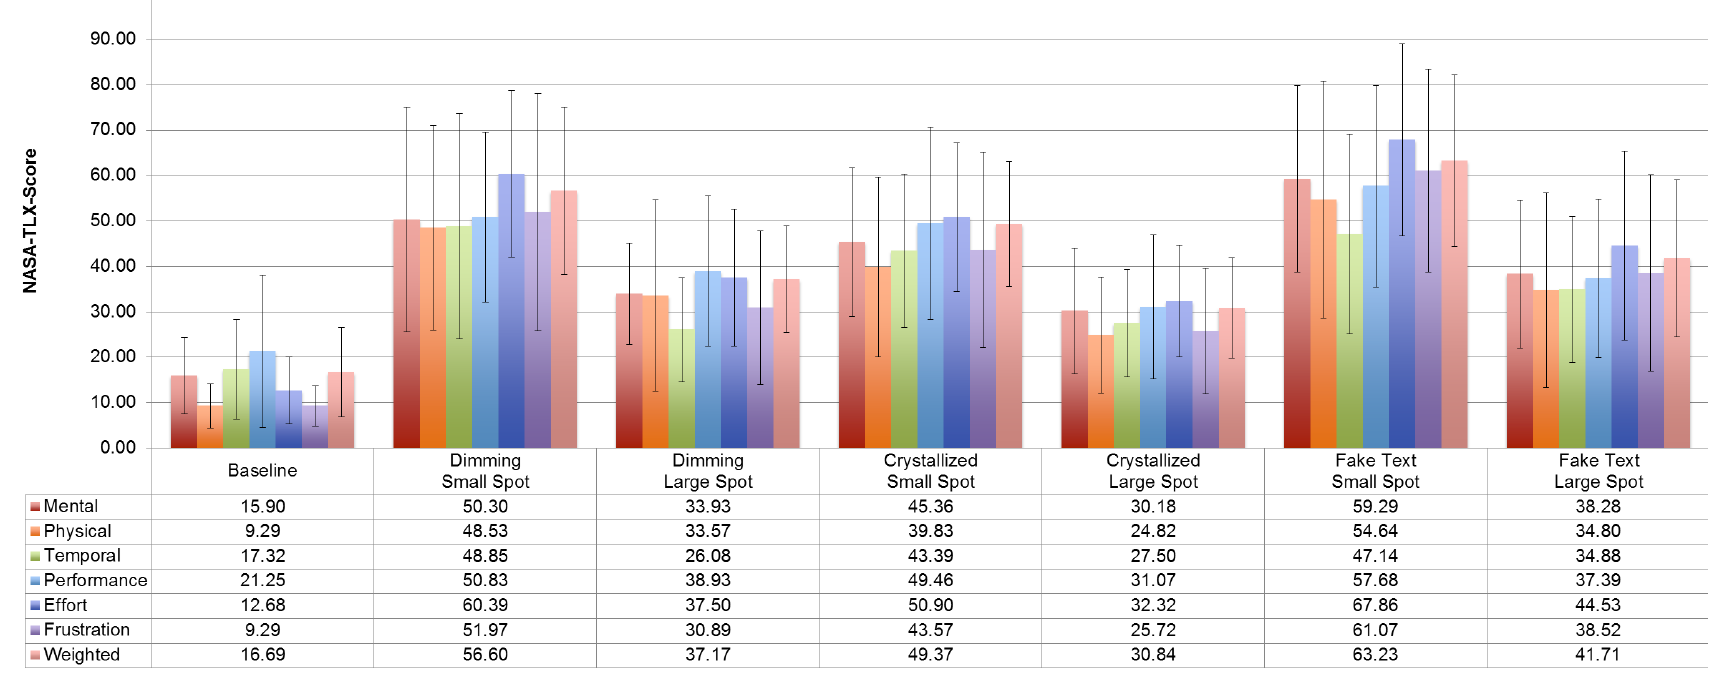
Figure 4. The figure shows the weighted results of the NASA TLX questionnaire administered using an online tool (https://www.keithv.com/software/nasatlx/ nasatlx.html). No significant differences were found, which means there is no evidence that one mask is more demanding than the other. However, visual inspection of the figure suggests a trend whereby using a large spot and a crystallized mask is associated with the least demand, while fake text mask is highly demanding with both spot